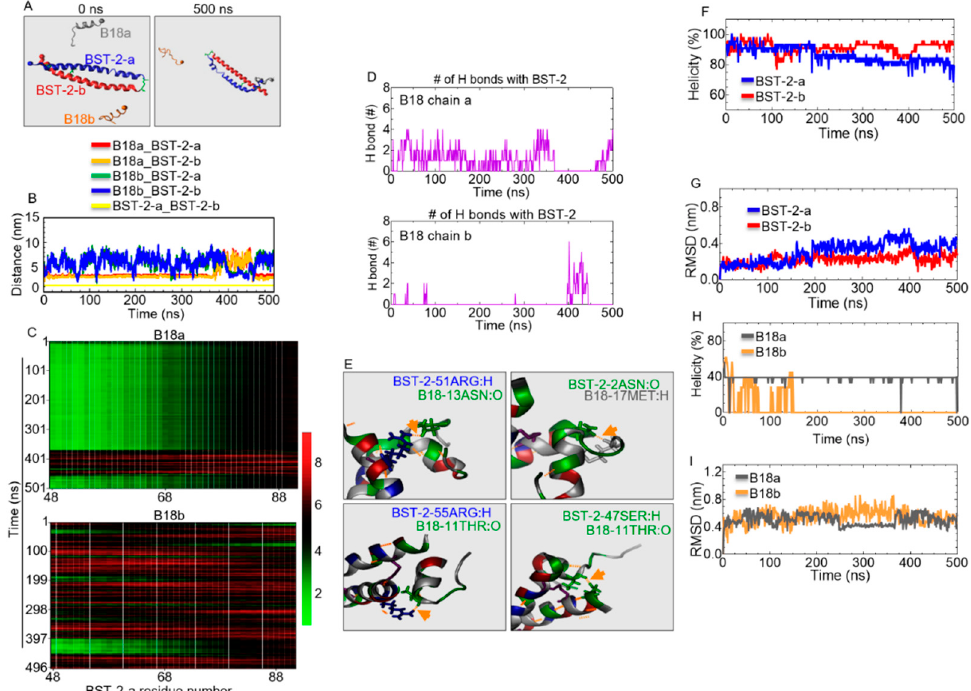
Figure 7. Predicted potential interaction between B18 peptides with the extracellular domain of BST-2. ( A ) Initial (t = 0 ns) and final (t = 500 ns) snapshots of MD simulation. Color code: blue: BST-2 chain a, red: BST-2 chain b, gray: B18 chain a, orange: B18 chain b. ( B ) Evolution of center of mass (COM) distance between each chain in the system. ( C ) COM distance of B18 chain a (top) and B18 chain b (bottom) with COM of BST-2 chain a protein as a function of time. Green means binding, and red means non-binding. ( D ) The number of hydrogen bonds (H bonds) of B18 chain a (top) and B18 chain b (bottom) with BST-2 protein as a function of time. ( E ) Representative images of hydrogen bonds (orange arrows) between B18 peptides and BST-2 protein. ( F ) The helicity of BST-2 chains as a function of time. ( G ) Root-mean-square deviation (RMSD) of BST-2 chains as a function of time. ( H ) The helicity of B18 chains as a function of time. ( I ) RMSD of B18 chains as a function of time.